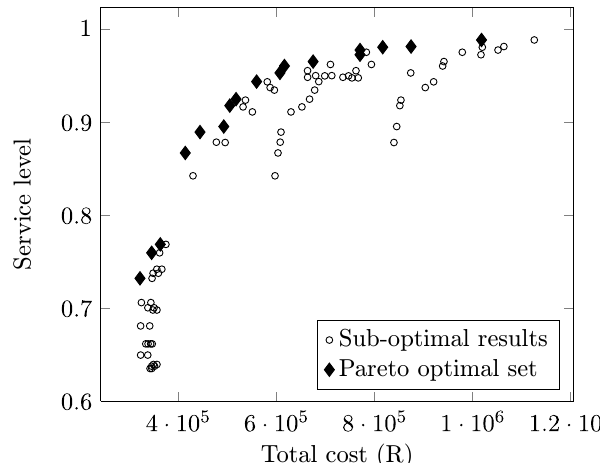
Figure 10: The set of Pareto optimal solutions for the MOO problem. All solutions in this set come from the subset of adjusted cost scenarios, which shows that the current cost agreement can be improved.